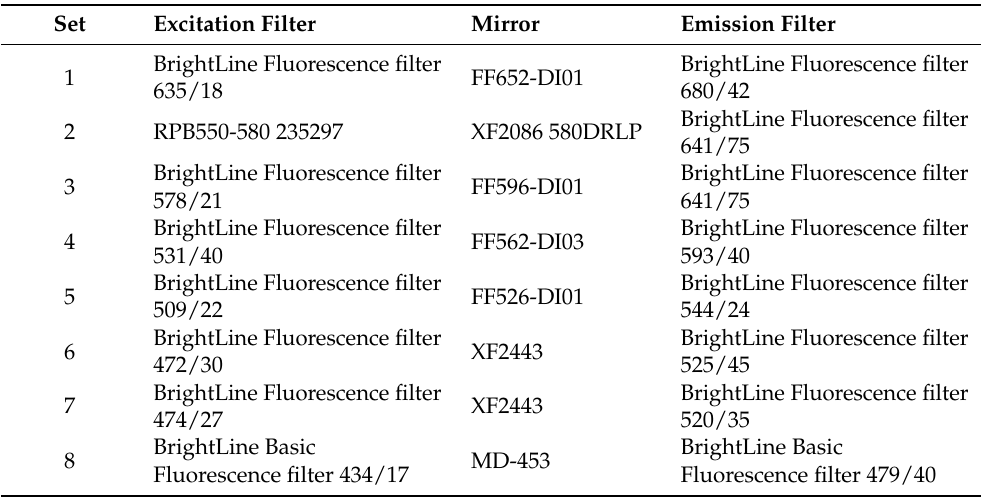
Table 2. Microscope filter set component